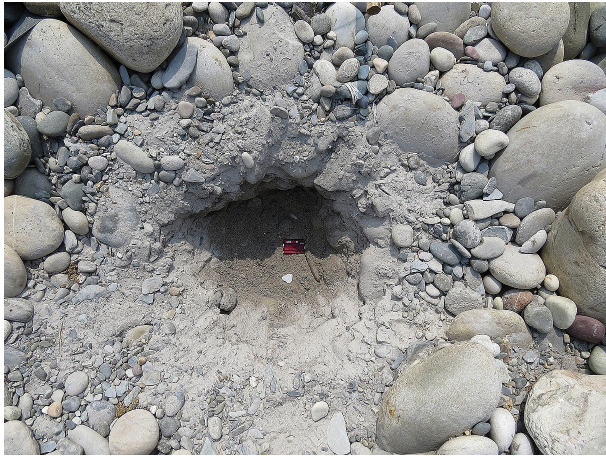
Figure A1. BGM – sieved from upper layer of modern gravel bar; 82mm long penknife in base of pit.